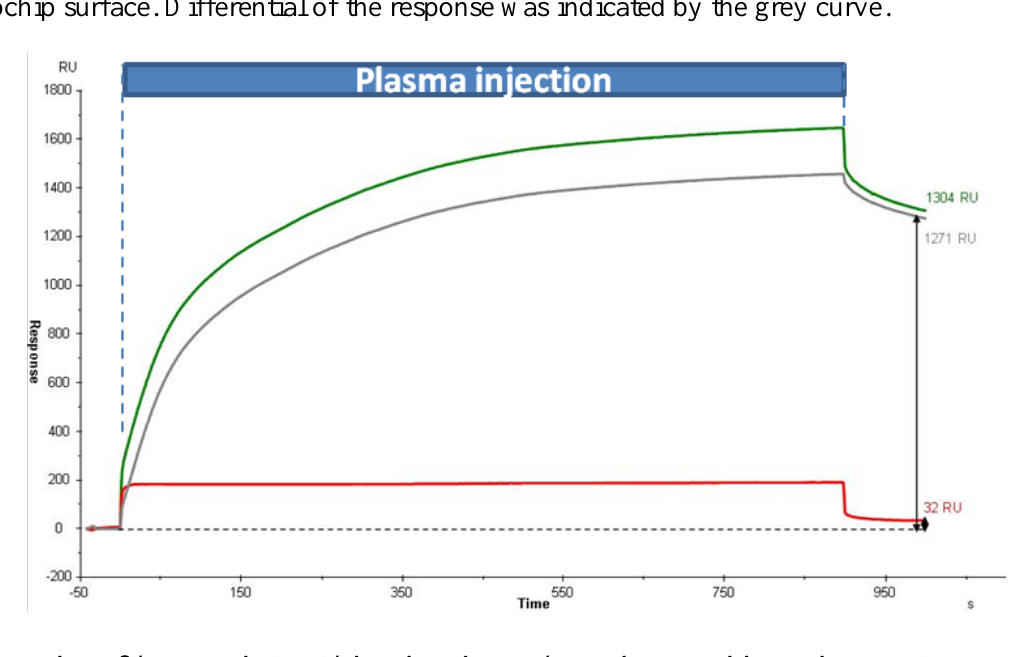
Figure 2. Sensorgram of interaction between LAG3 capture in diluted human plasma (2.5%) spiked with LAG3 (12.5 nM) with α-LAG3 (green curve) and α-RSA (in red) biochip surface. Differential of the response was indicated by the grey